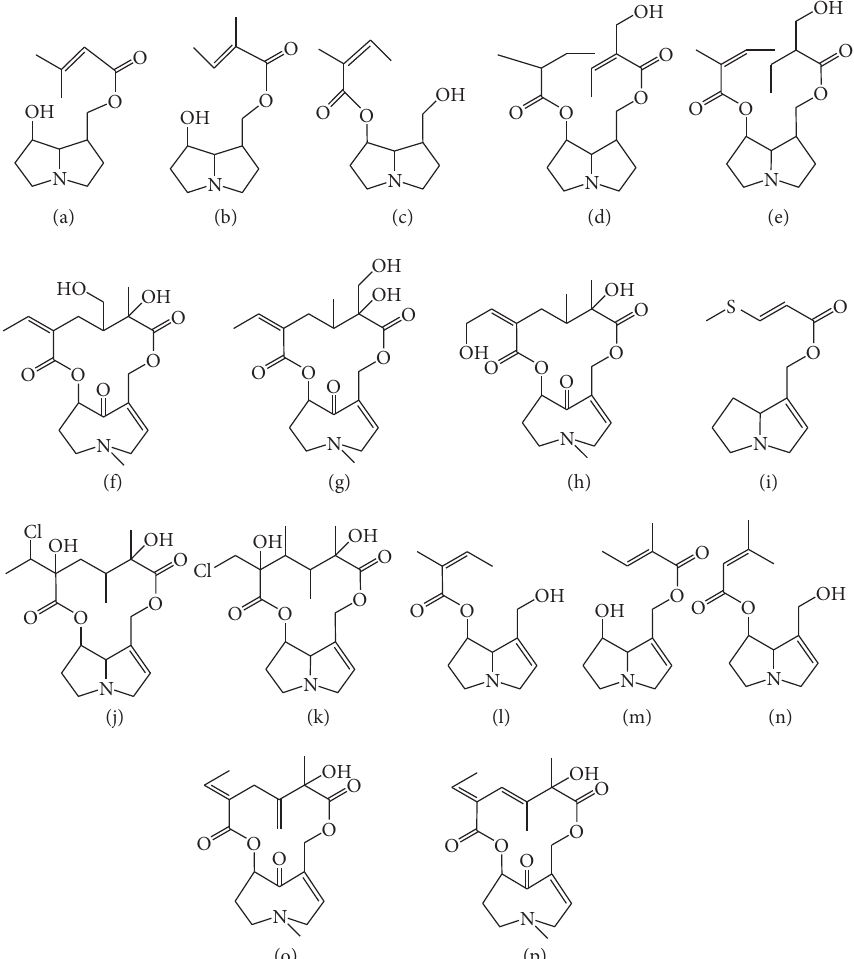
Figure 5: Probable structures of several peaks. (a) Fuchsisenecionine. (b) Racemocine. (c) 7-Angeloylturneforcidine. (d) Dihydro-Sarracine. (e) Dihydro-Sarracine. (f) 18-Hydroxysenkirkine. (g) Hydroxysen kirkine. (h) Anonamine. (i) Planchonelline. (j) Jaconine. (k) Merenskine. (l)